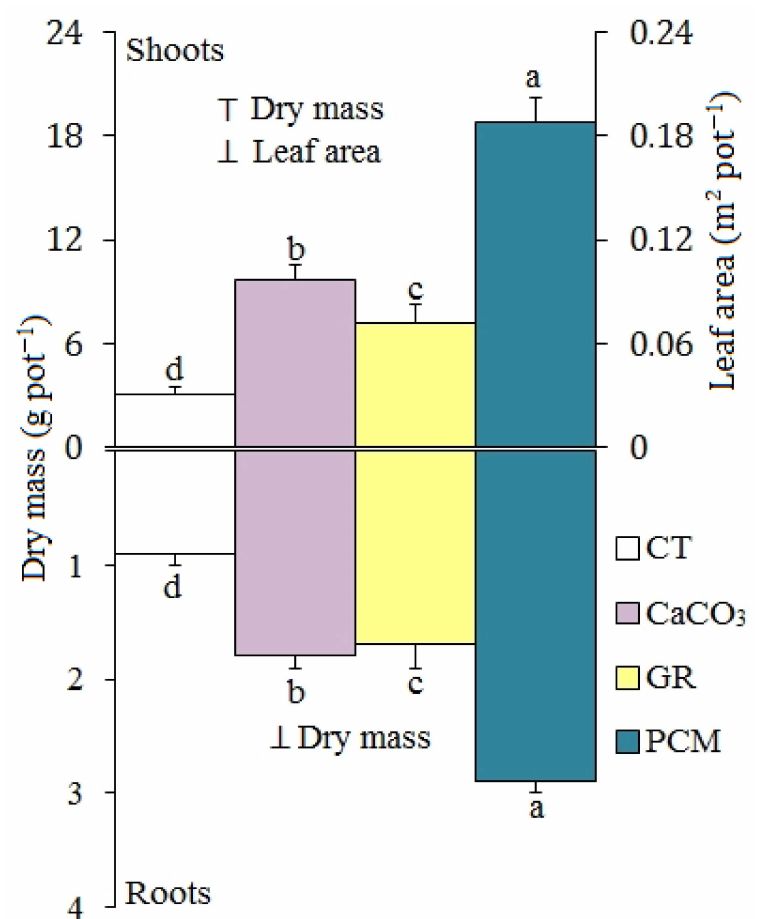
Figure 3. Jack bean dry mass and leaf area obtained in the treatments. CT = Control, GR = Coffee grounds biochar, and PCM = Coffee parchment biochar. Columns with the same letter are not different ( p ≤ 0.05). Error bars indicate de standard deviation (n =